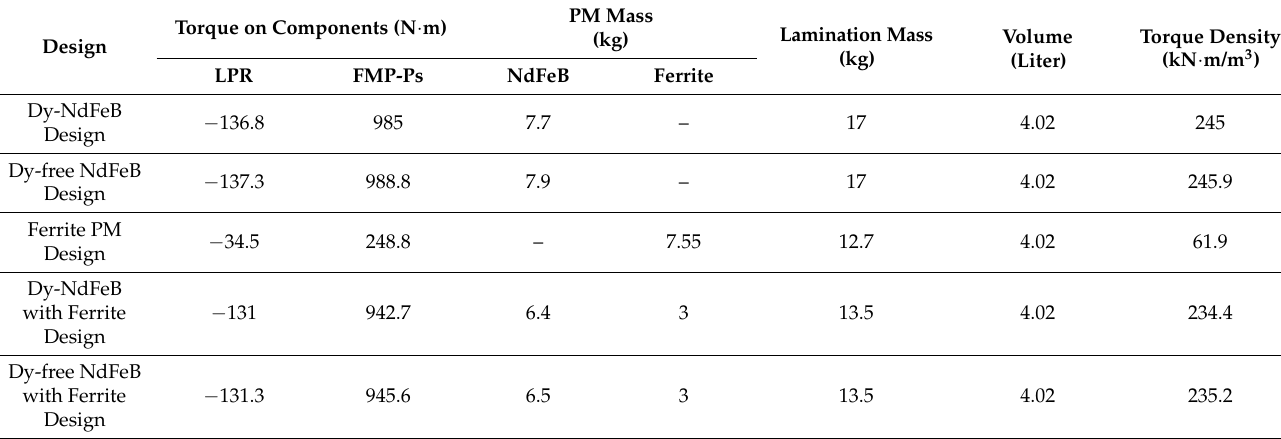
Table 6. Performance of various designs as well as PM